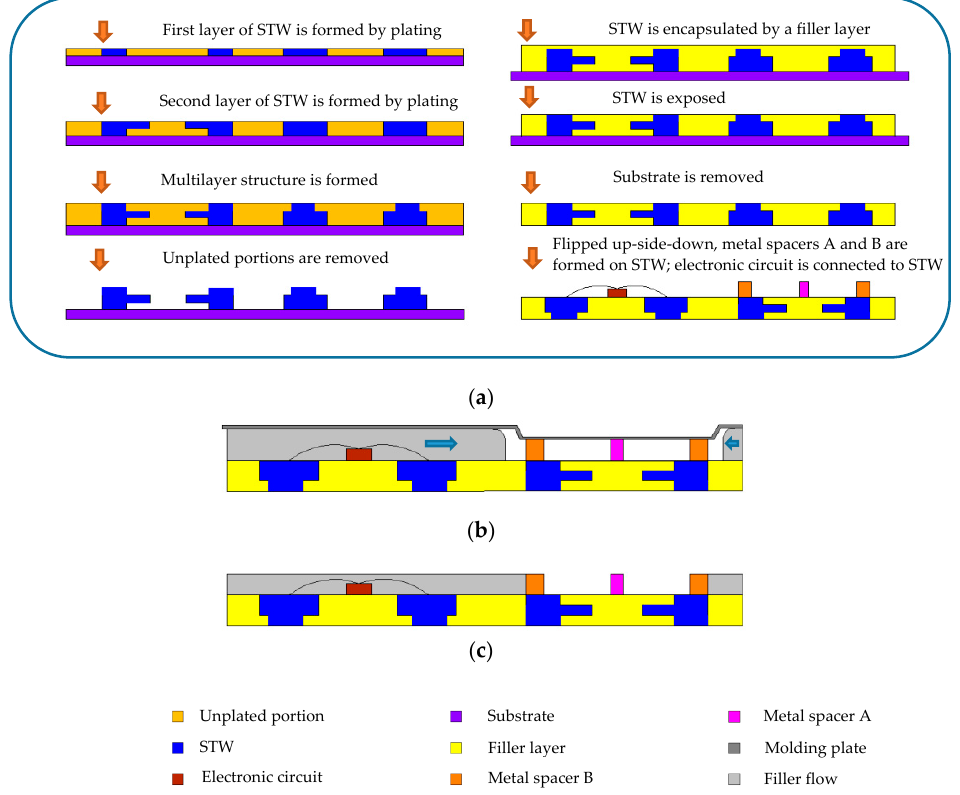
Figure 2. ( a ) Manufacturing flow of biocell; ( b ) Space (i.e., open cavity) is formed between the molding Figure 2. (a) Manufacturing flow of biocell; (b) Space (i.e., open cavity) is formed between the molding plate and carrier; ( c ) Biocell test region is plate and carrier; (c) Biocell test region is formed.